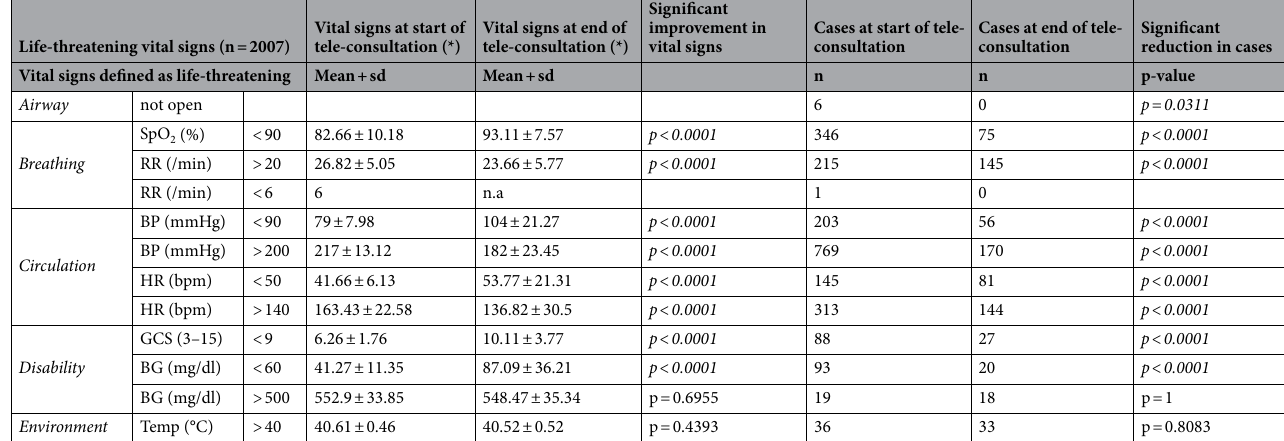
Table 2. Cohorts in missions involving patients with initially life-threatening vital signs. The left box shows the means and standard deviations for the vital signs in initially critically ill patients before and after teleconsultation. The right box shows the number of cases with initially life-threatening vital signs at the start and end of the teleconsultation. Sd standard deviation, SpO 2 oxygen saturation, RR respiratory rate, BP blood pressure, HR heart rate, GCS Glasgow Coma Scale, BG blood glucose, Temp temperature. *Unit depending on vital sign, n.a. = data was not available. Italicized p-values are significant.